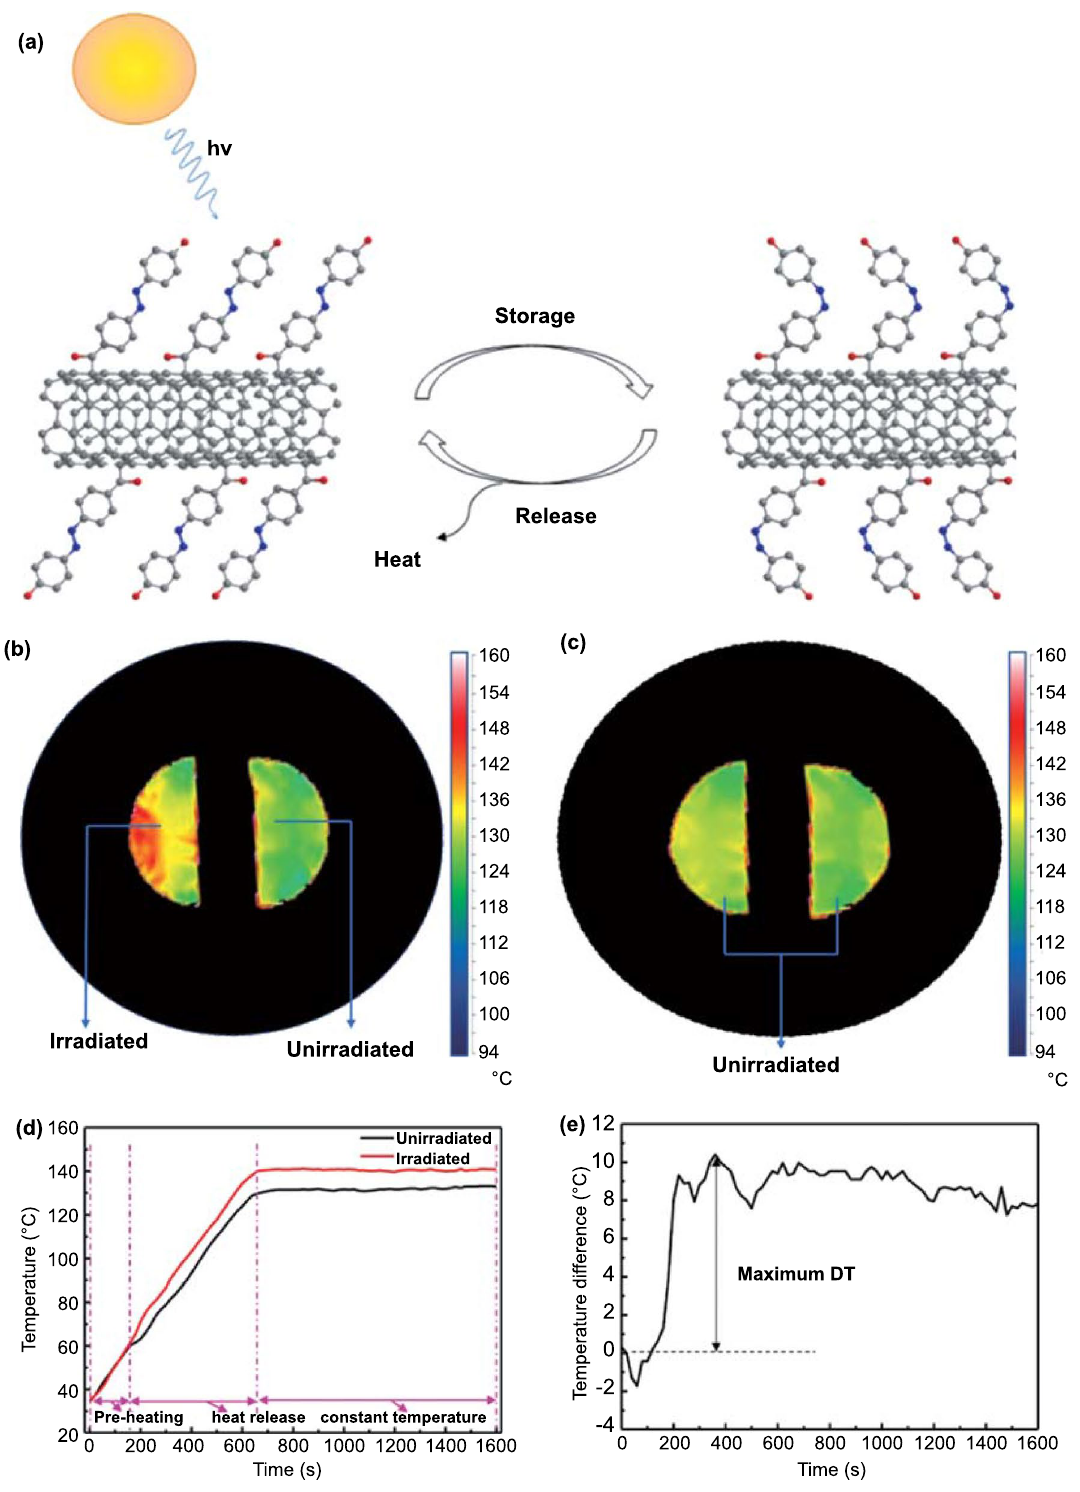
Fig. 13 a Schematic of the Azo-SWCNTs STFs based on the photoinduced isomerization. b Azo-SWCNTs film with and without irradiation. c Both Azo-SWCNTs films absorbed no UV light. d Average temperature on the surface of Azo-SWCNTs film. e Average DT between Azo- SWCNTs film with and without irradiation